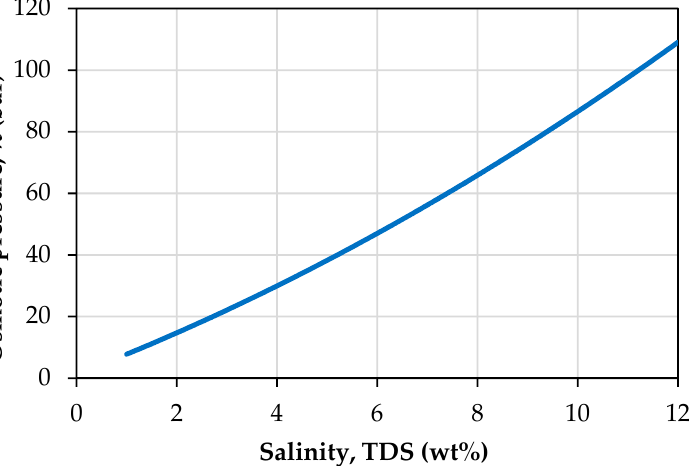
Figure 1. Osmotic pressure of seawater and its diluted and concentrated solutions as a function of the TDS at 30 °C.